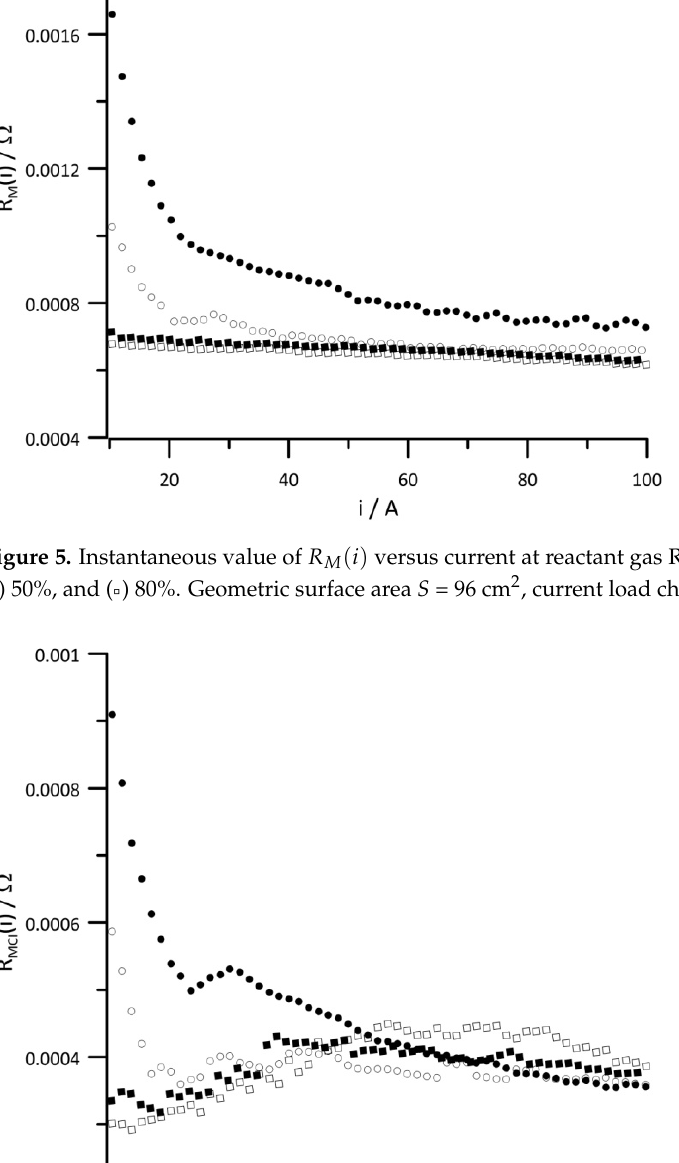
Figure 3. Impedance spectra of the PEMFC middle cell obtained in galvanodynamic mode. Geometric surface area S = 96 cm 2 , current load change rate d i /d t = 40 mA s − 1 , and measurement frequencies range from 5–1123 Hz. RH of reactant gases ( A ) 10%, ( B ) 30%, ( C ) 50%, and ( D ) 80%. The I - V characteristics recorded for supplied reagents with a humidity of 80% devi- ated from the other characteristics in the entire current range. Based on this simple anal- ysis, it can be concluded that a humidity of 80% is too high and adversely affects the fuel cell operation over the entire current range. Analyzing the voltage changes of the re-